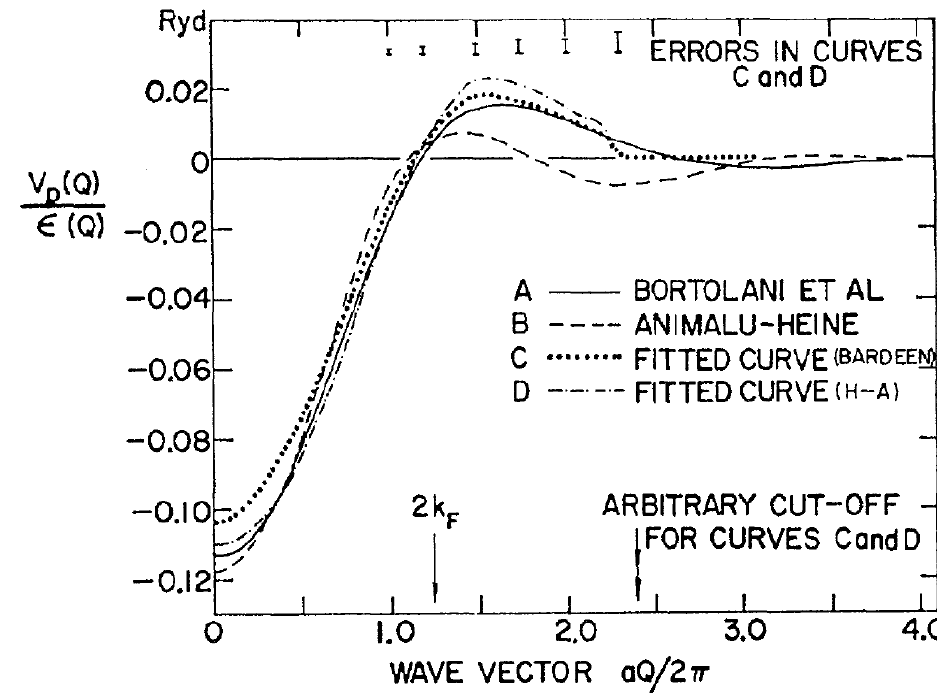
Figure 25. The screened pseudopotential for the conduction electron–ion interaction V p (Q)/ ε (Q) in potassium at 9 K. A and B are theoretical curves based on the Heine–Abarenkov model, while C and D are fitted to the phonon data. Curve D resembles case A, as determined by Bortolani. This figure is taken Figure 5 of ref. [65]. Copyright by the American Physical Society.